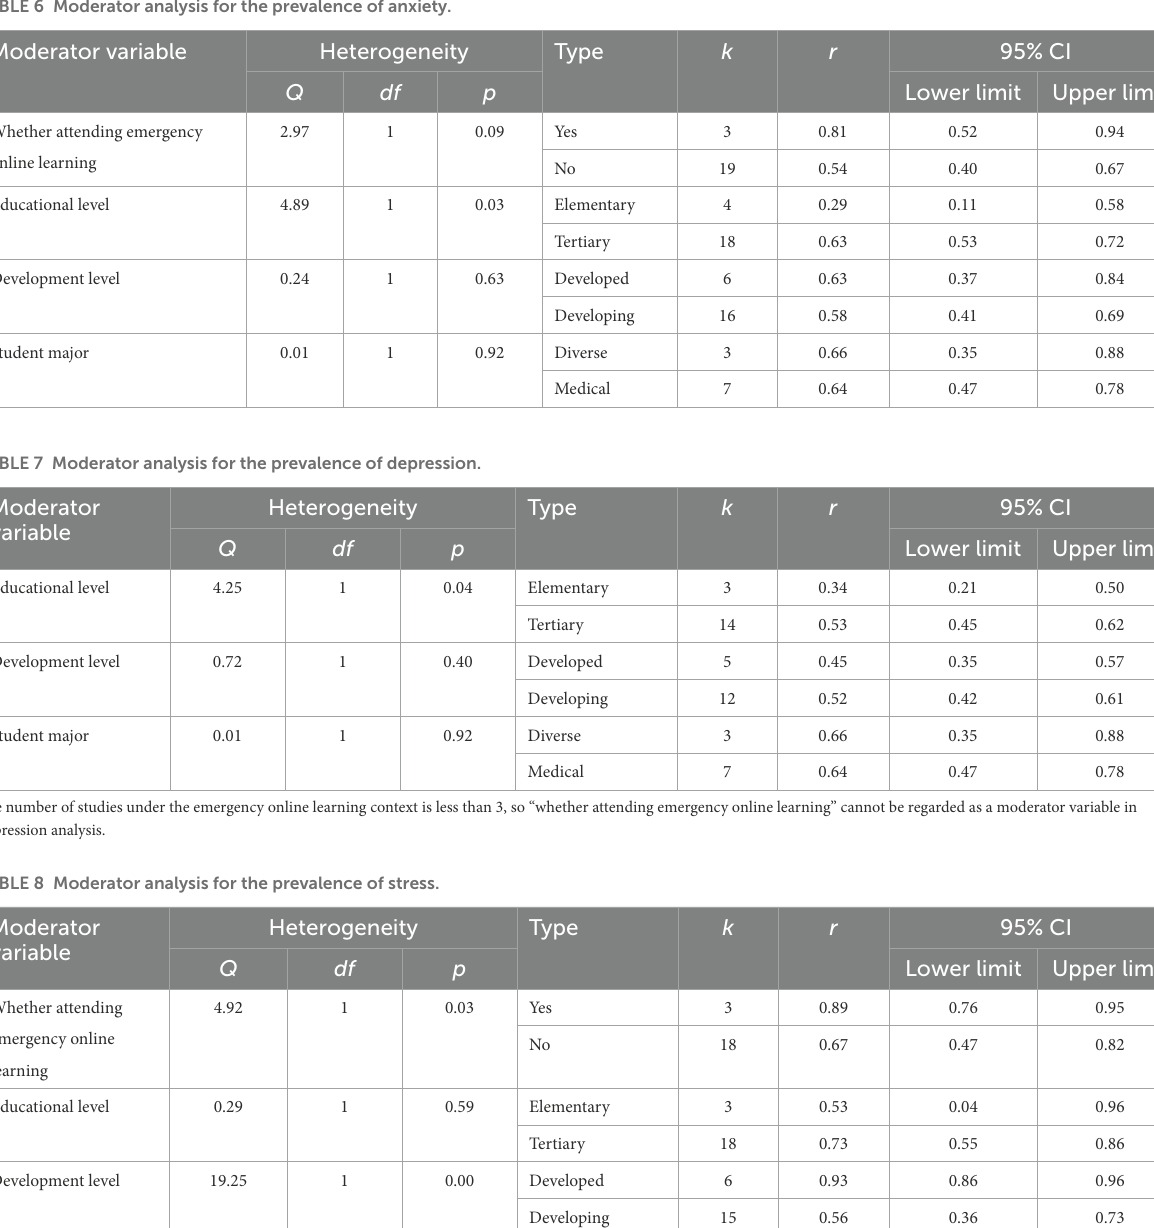
TABLE 6 Moderator analysis for the prevalence of